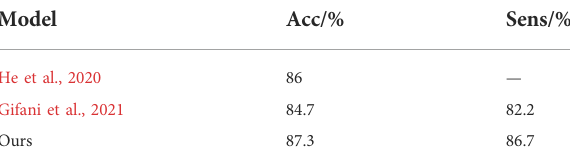
TABLE 3 Model comparison of COVID-19 CT dataset.